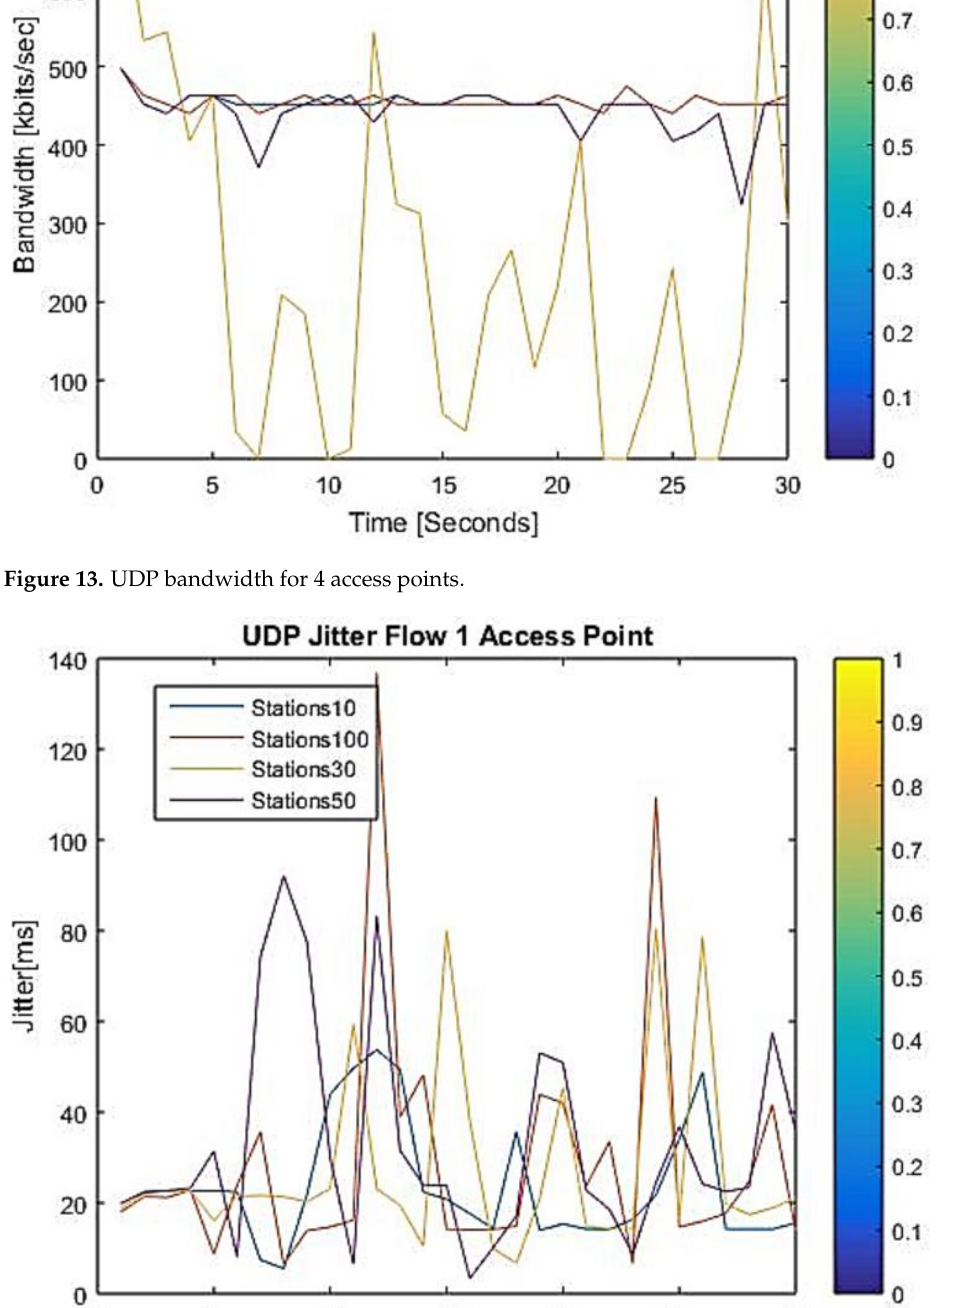
Figure 14. UDP jitter for 1 access point.